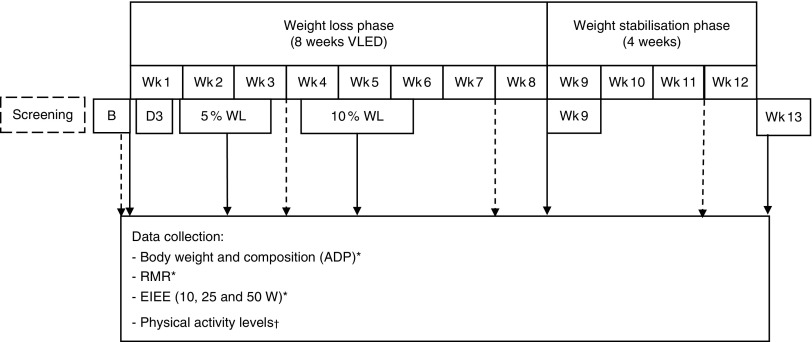
Study diagram. For data collection points, see arrows. Wk, weeks; VLED, very-low-energy diet; ADP, air-displacement plethysmography; EIEE, exercise-induced energy expenditure. * ; † .